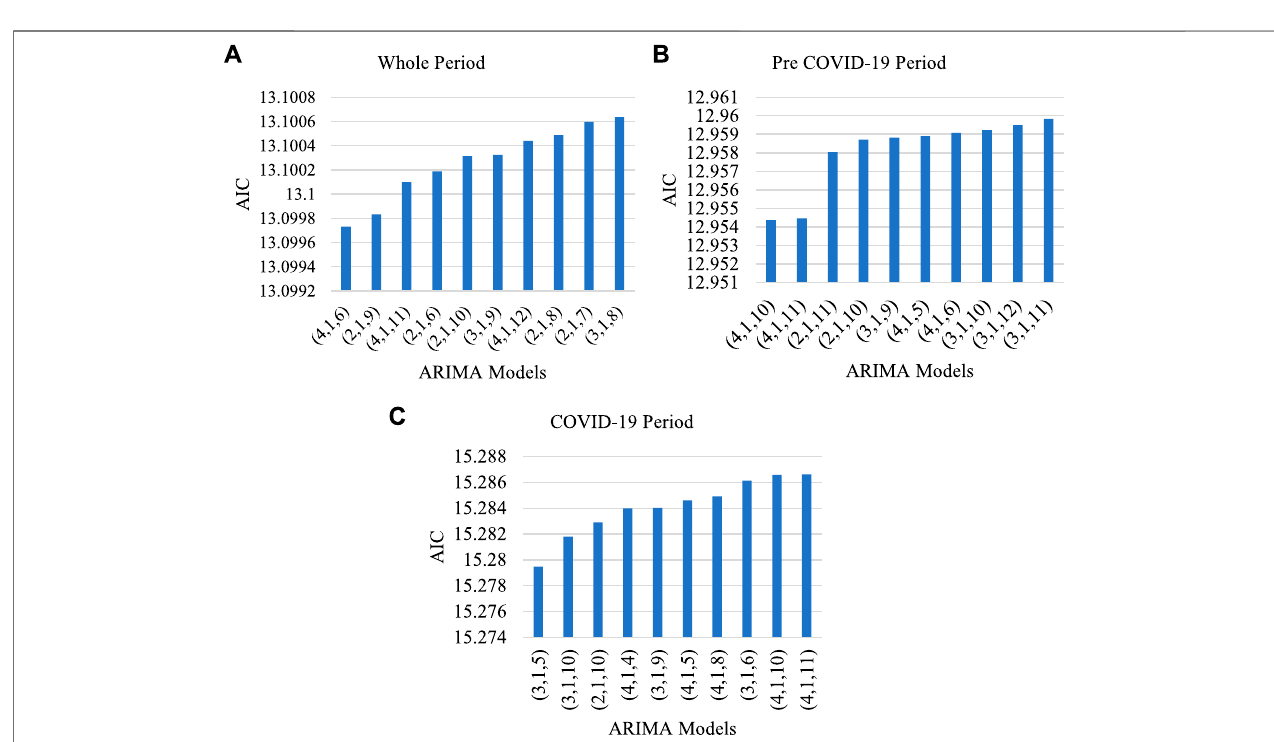
Frontiers in Environmental Science |